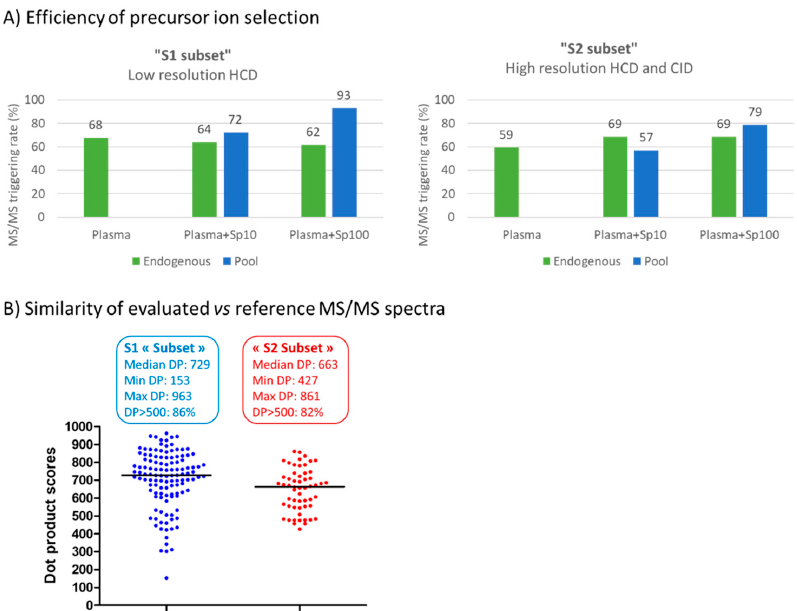
Figure 4. Performance characteristics of the low- and high-mass resolution DDA acquisition workflows on S1 and S2 subsets, respectively. ( A ) Efficiency of precursor ion selection and ( B ) distribution of dot product scores for S1 and S2 subsets. Plasma + Sp10 or Plasma + Sp100 correspond to plasma extracts spiked at 10 and 100 ng/mL, respectively.